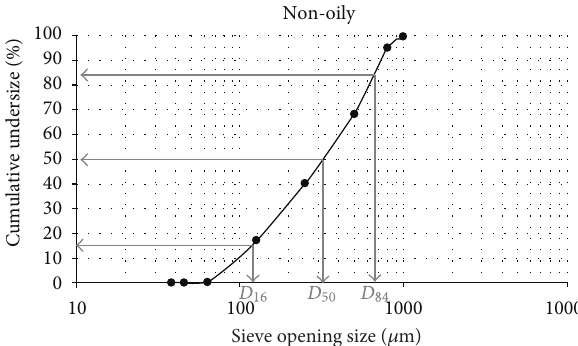
F 2: Lognormal distribution plot of cumulative undersize percentage of non-oily POME